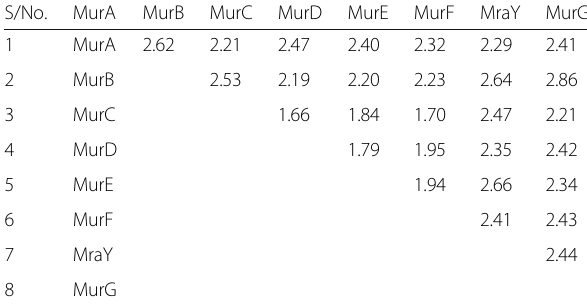
Table 5 Pairwise distance statistics of eight Mur proteins from A . baumannii S/No.